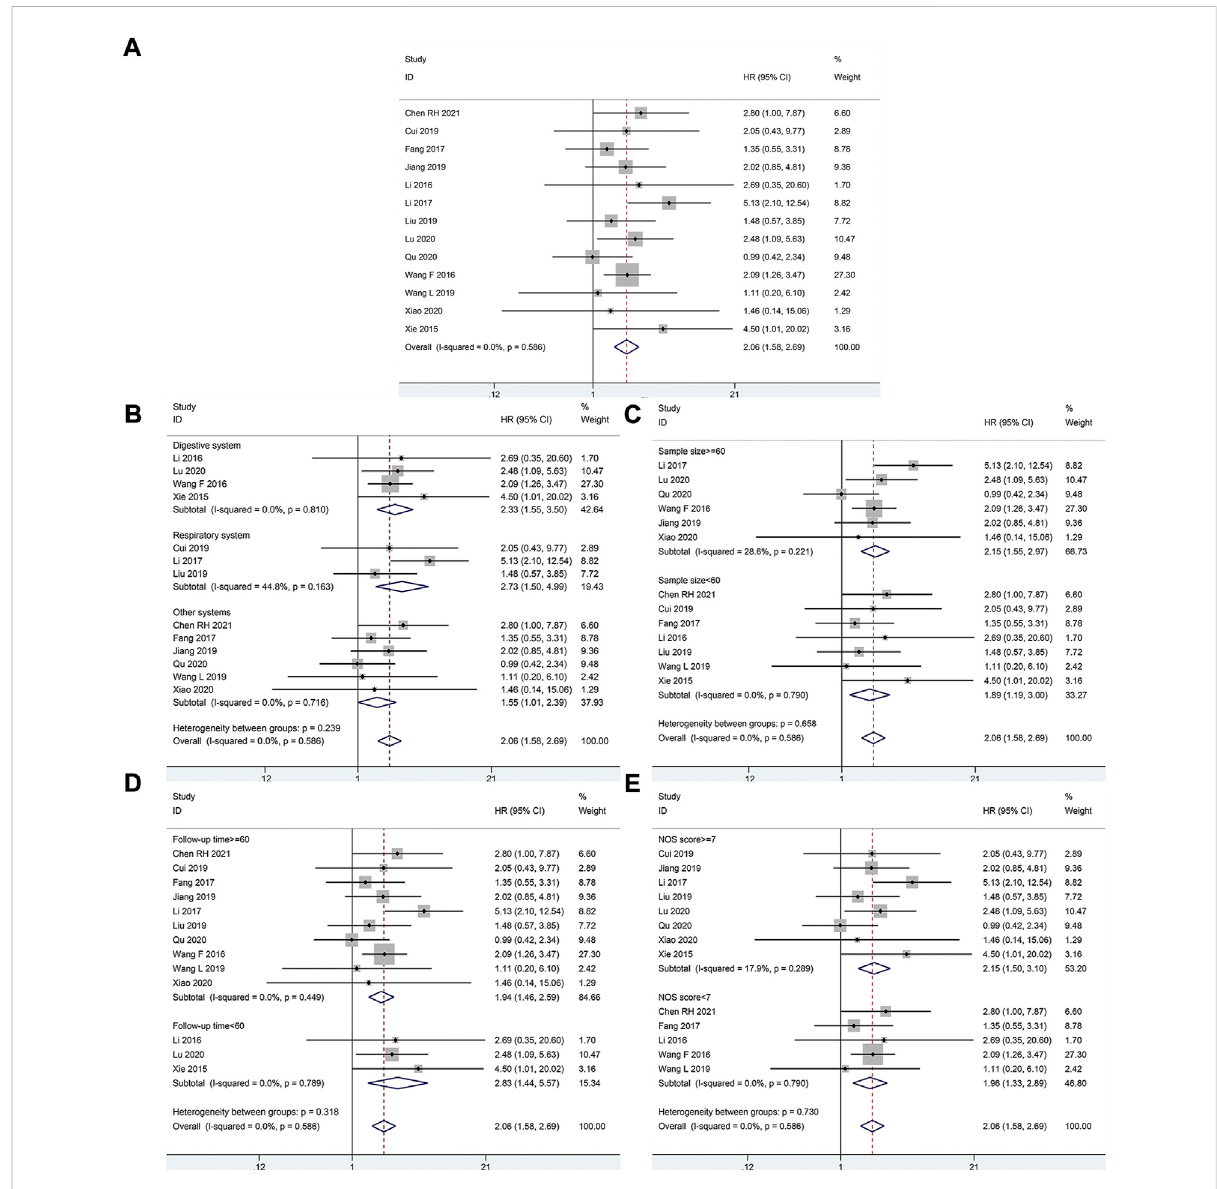
FIGURE 2 Relationship between HOXA-AS2 expression and overall survival. (A) Forest plots for association of HOXA-AS2 expression with overall survival. (B) Subgroup analysis strati fi ed by cancer type. (C) Subgroup analysis strati fi ed by sample size. (D) Subgroup analysis strati fi ed by follow-up time. (E) Subgroup analysis strati fi ed by NOS